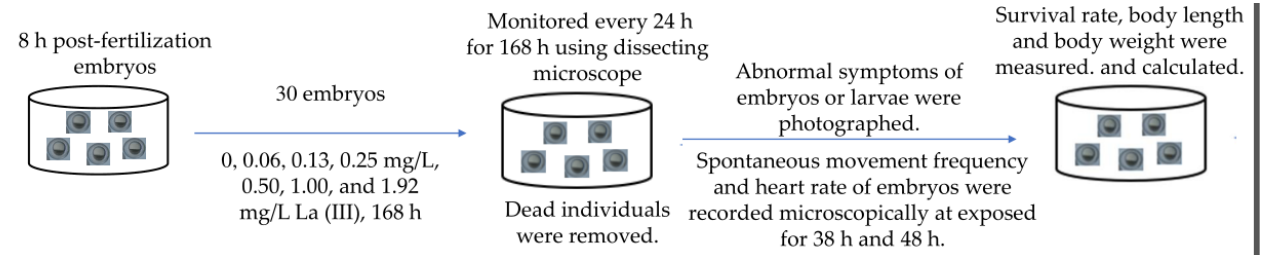
Figure 1. The experimental design of the chronic toxicity assay of embryonic and sac-fry stages.